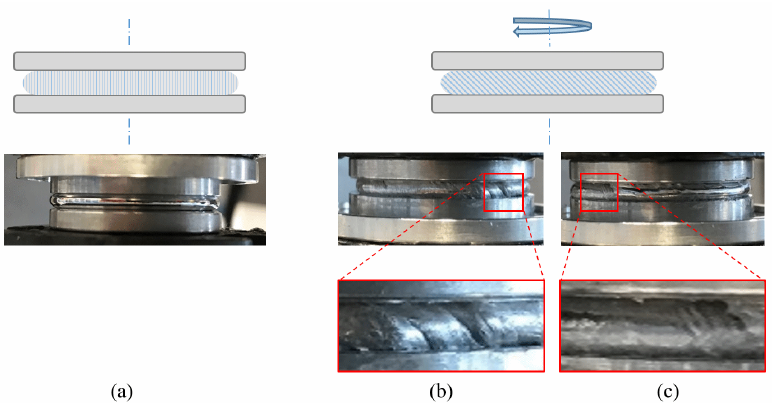
Figure 6. Graphic scheme and pictures of liquid metal samples between the two parallel plates of the rotational rheometer during torsional flow tests: ( a ) Initial state. ( b ) Detail of buckling of the oxide skin of Field’s metal and ( c ) EGaIn.